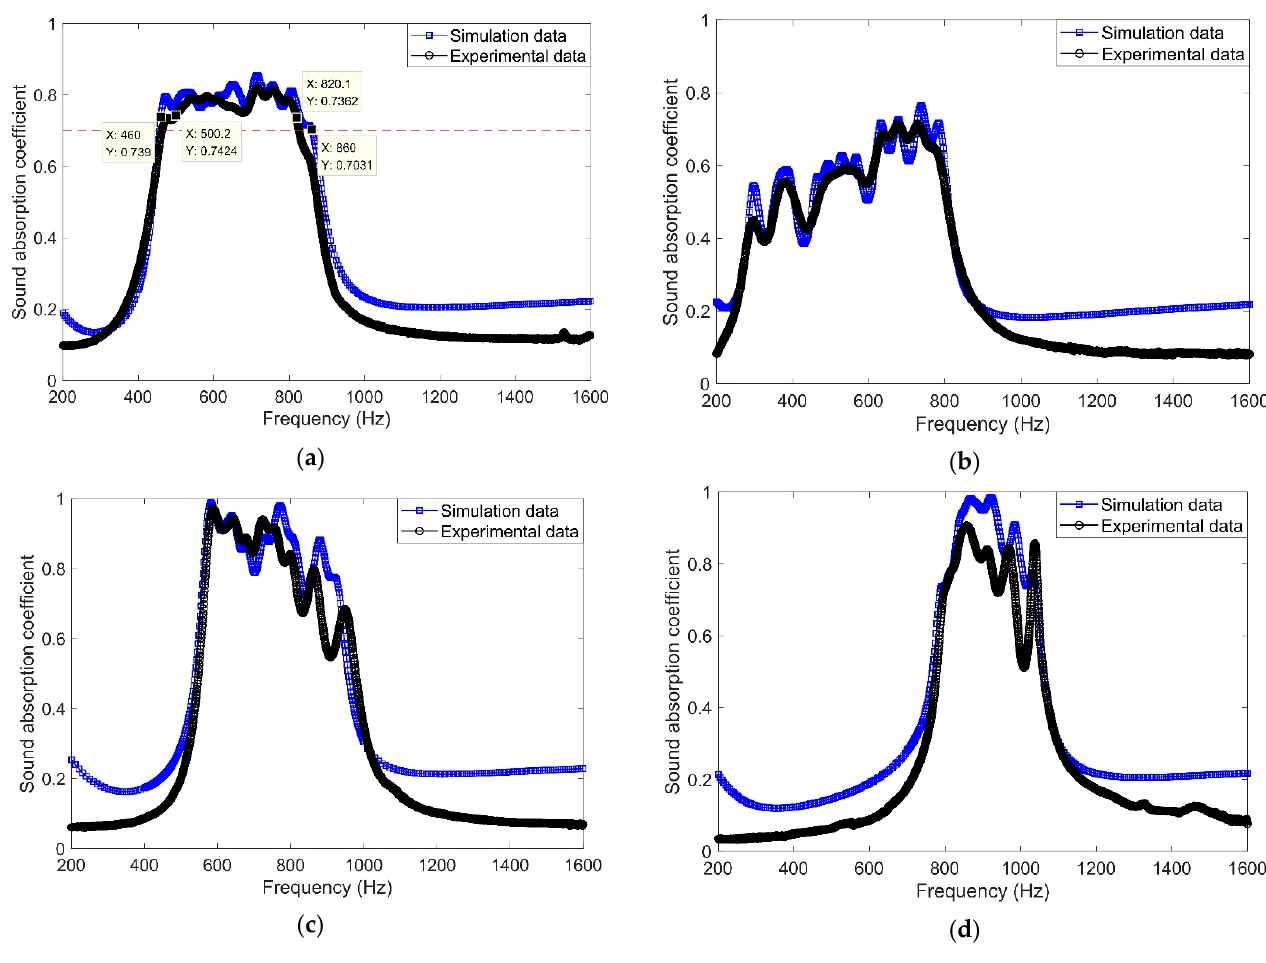
Figure 18. The comparison of sound absorption coefficients obtained in the simulation with those achieved in impedance tube measurement. ( a ) The proposed acoustic metamaterial in this research; ( b ) the multiple parallel connection HRs with normal cylindrical aperture for the radius of R u ; ( c ) the multiple parallel connection HRs with normal cylindrical aperture for the radius of (R u + R m )/2; and ( d ) the multiple parallel connection HRs with normal cylindrical aperture for the radius of R m .